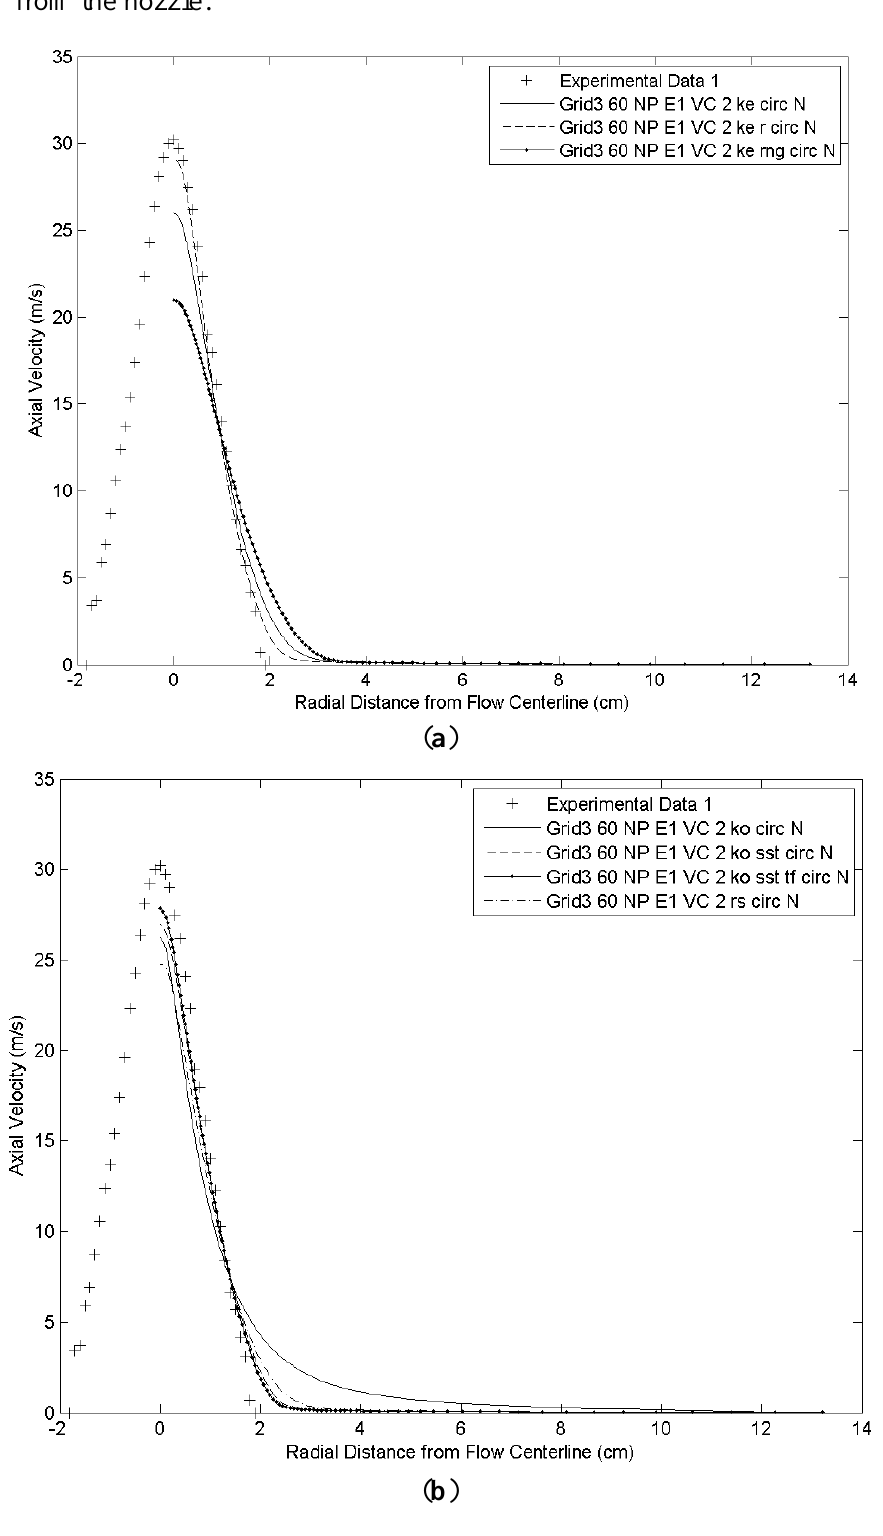
Figure 17. Comparison with experiment of results from ( a ) standard k -  (ke), k -  realizable (ke r) and RNG k -  (ke rng) models at z = 10 cm from the nozzle; ( b ) standard k -ω (ko), k -ω sst (ko sst), k -ω sst tf (ko sst tf) and the Reynolds Stress (rs) models at z = 10 cm from the